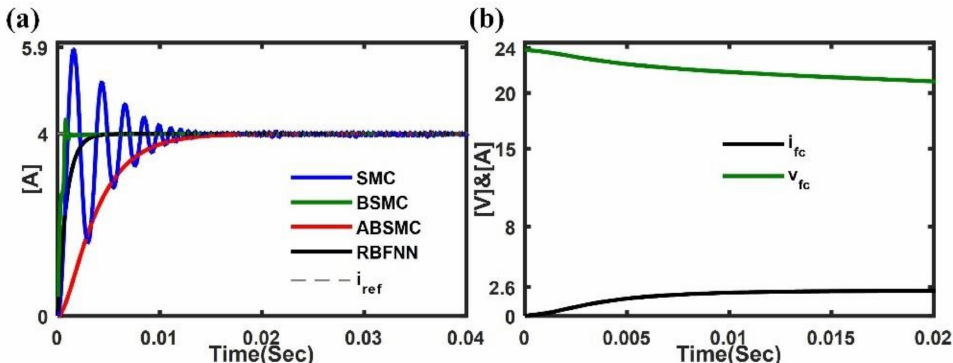
Figure 3. Simulation results in Condition 1: ( a ) by different control methods; ( b ) PEMFC current and voltage response when regulated by RBFNN.